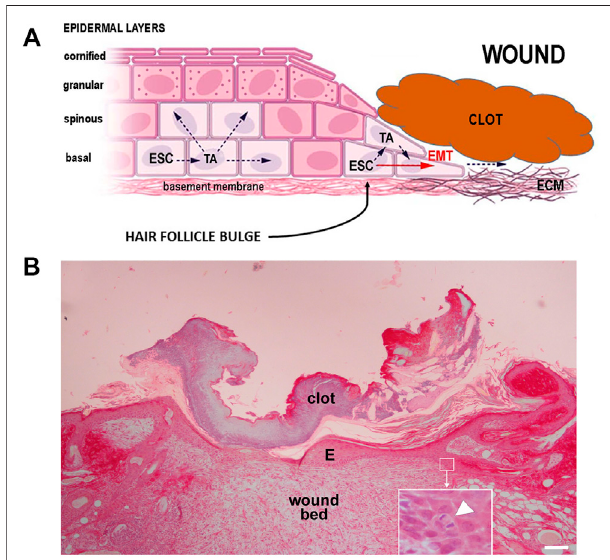
FIGURE 1 | (A) Schematic diagram of epidermal keratinocyte proliferation and migration during wound closure: ESC, epidermal stem cells; TA transit amplifying cells; EMT, epithelial-mesenchymal transition; ECM, extracellularmatrix. (B) Woundhealinginratskin:athin, fl attenedlayerof newly formed epidermis (E) lies over the wound bed and under the clot; the inset shows a detail of an ESC undergoing mitosis (arrowhead). Hematoxylin, picrosirius red, scale bar = 100 μ m (courtesy Dr. P.